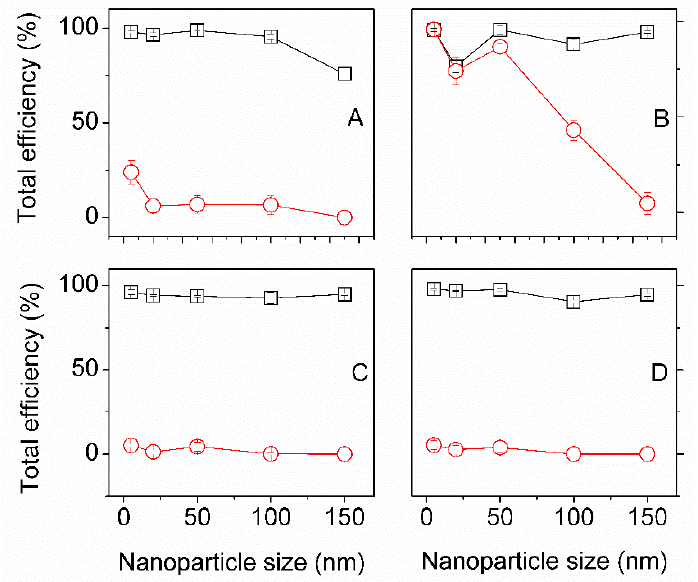
Figure 2. Comparison of total efficiency at supercritical and control impregnation of Indian silks: ( A ) Mulberry ( B ) Eri ( C ) Tasar ( D ) Muga with five different sizes of gold nanoparticle (5, 20, 50, 100 and 150 nm). Black squares ( (cid:3) ) are scCO 2 samples, red circles (O) are control samples. The control and scCO 2 efficiencies were significantly different (N = 30, p < 0, α = 0.05) for Mulberry, Tasar and Muga silks for all gold nanoparticles sizes. For Eri below 100 nm the efficiencies were not significant (N = 30, p 5nm = 0.35 p 20nm = 0.12 p 50nm = 0.09, α = 0.05), above 100 nm the efficiencies were significantly different (N = 30, p < 0, α = 0.05).